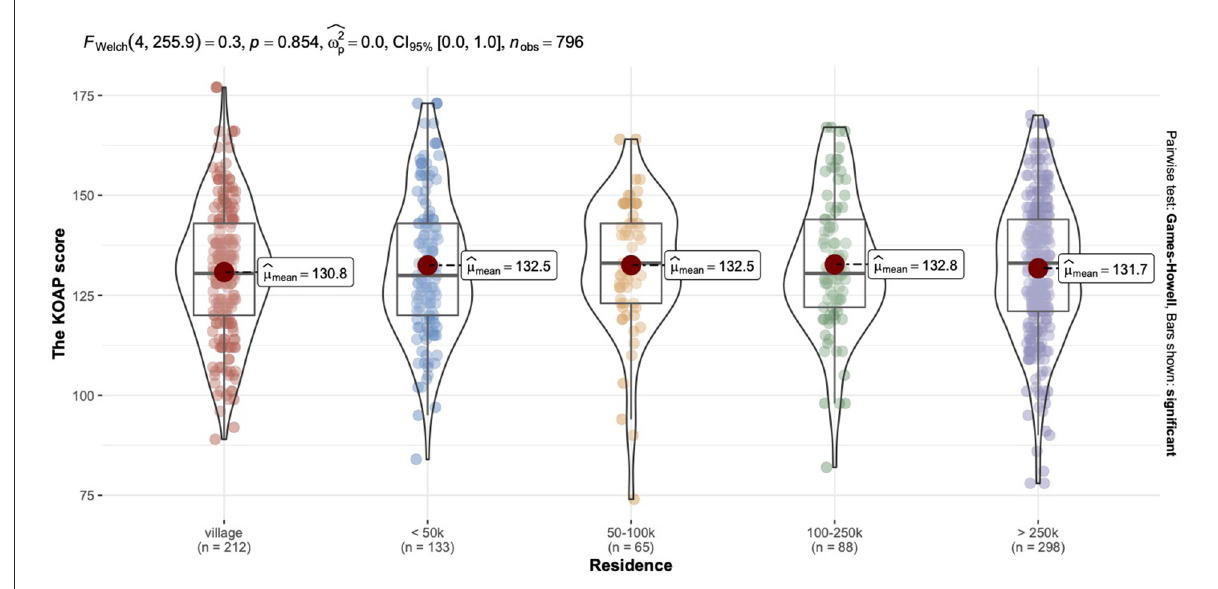
FIGURE1 Comparative characteristics of the KAOP mean scores grouped by residence.